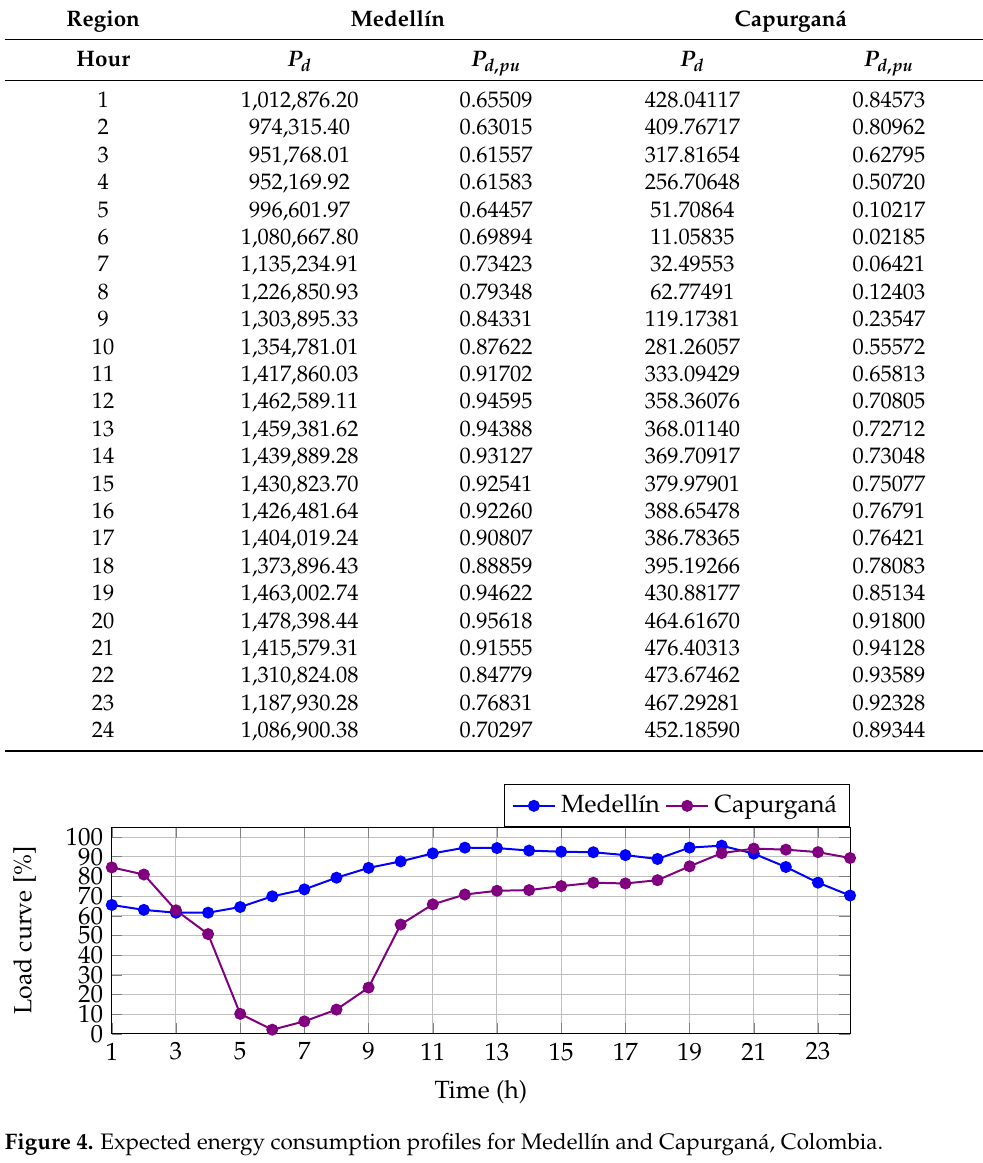
Table 3. Power consumption data (kW) and behavior (p.u.) for an average day in the regions under study.